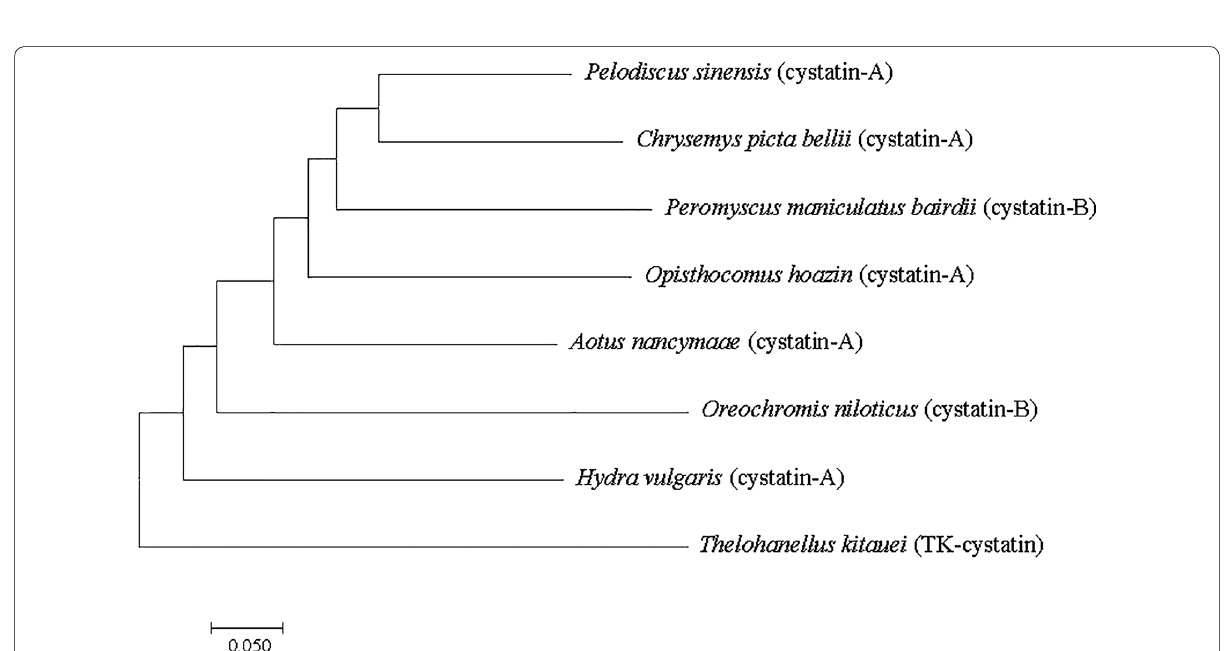
Fig. 3 Phylogenetic tree of TK-cystatin and other species homologous cystatins. Phylogenetic tree was constructed by MEGA 7.0 using the Neighbor-Joining algorithm. Bootstrap values from 500 replicates were given on the